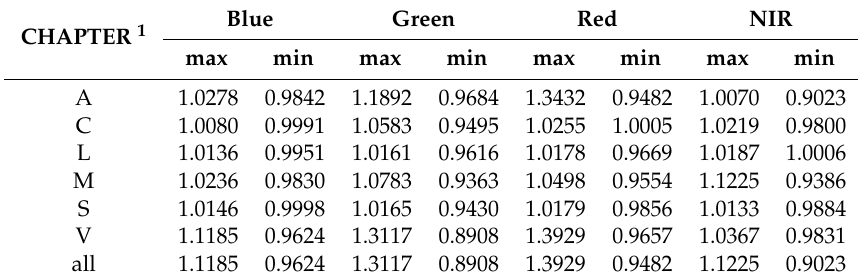
Table 5. The range of RSR adjustment factors for different surface features, which were estimated using the USGS spectral library, the chapters were followed the same convention of the